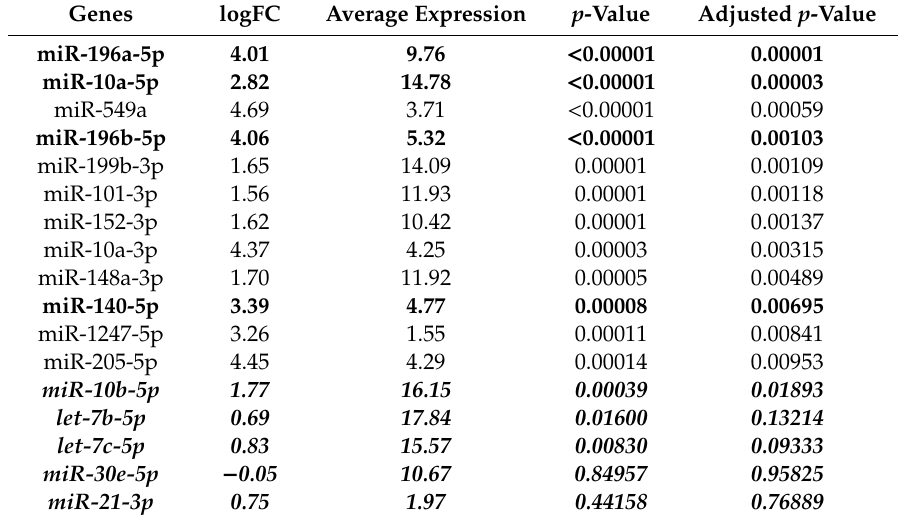
Table 3. MicroRNAs with the most significantly di ff erent levels in cerebrospinal fluid of meningioma patients in comparison to controls ( p < 0.001) supplemented with additional miRNAs tested in the validation phase of the study listed at the bottom of the table (in italics). All miRNAs selected for the validation phase are in bold; and logFC = binary logarithm of Fold Change.